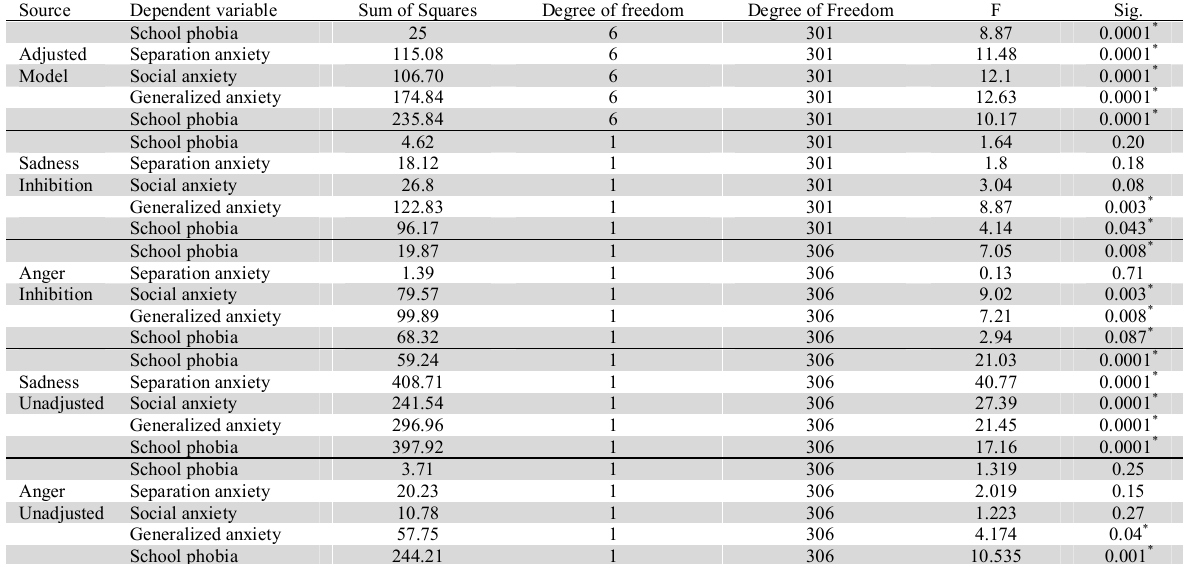
Source Dependent variable